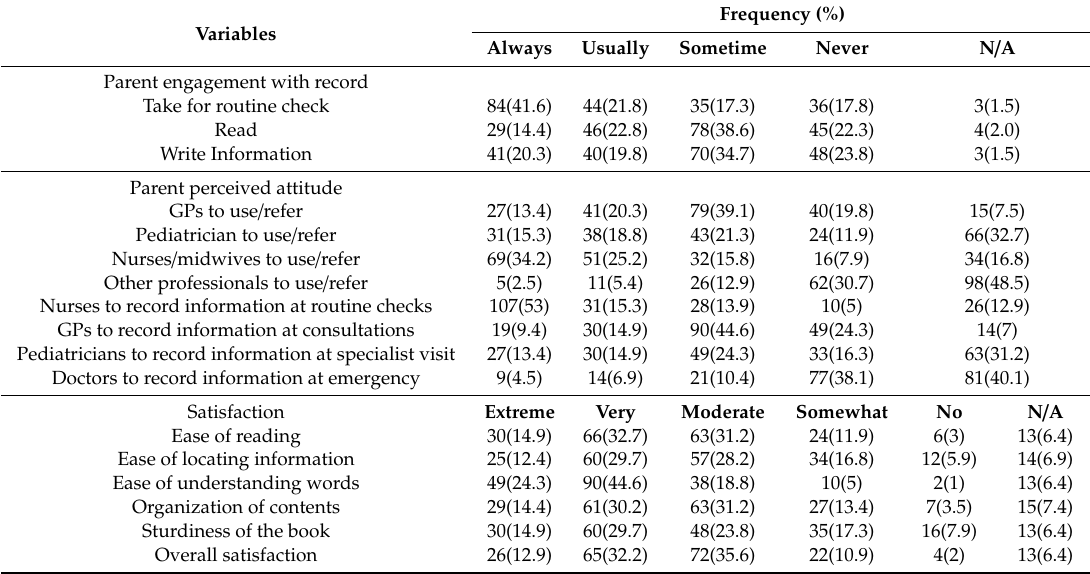
Table 2. Number (percentage) of reported utilization, perception and satisfaction ( N = 202).